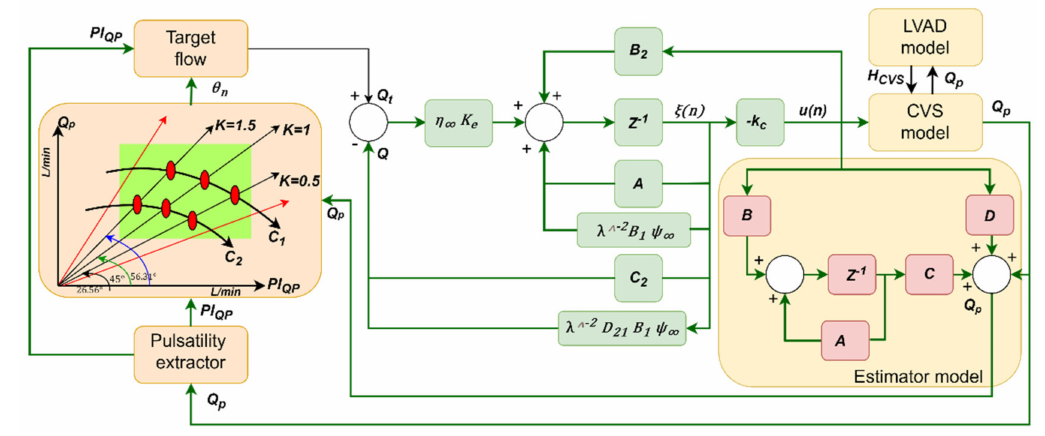
Figure 2. Physiological control